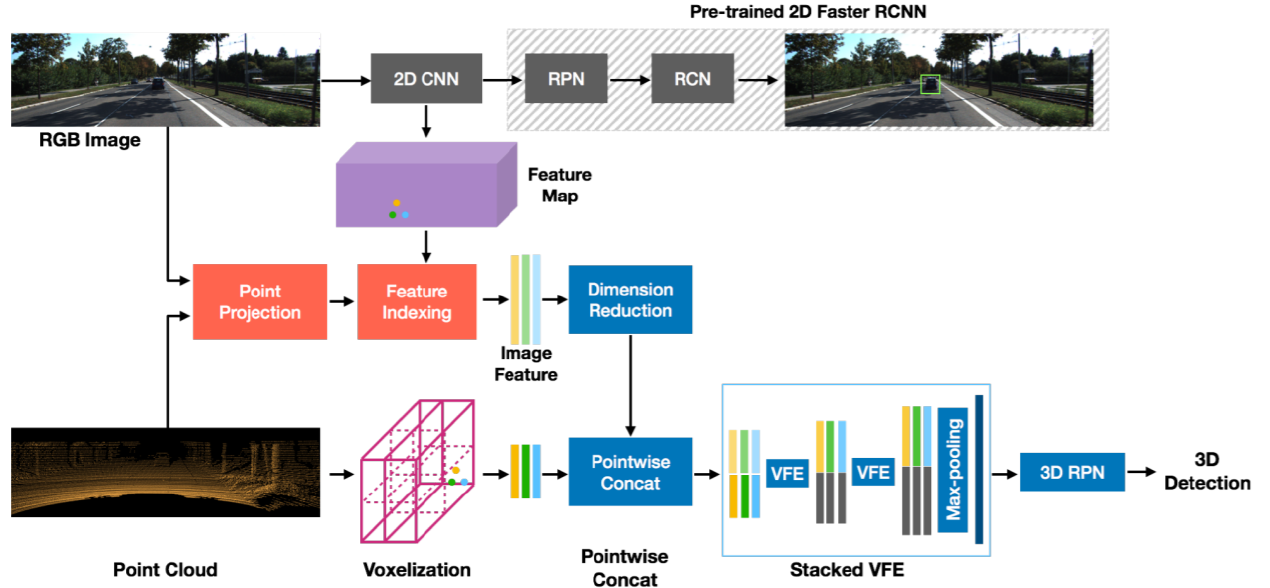
Figure 23. The overview of the MVX-Net [76] PointFusion